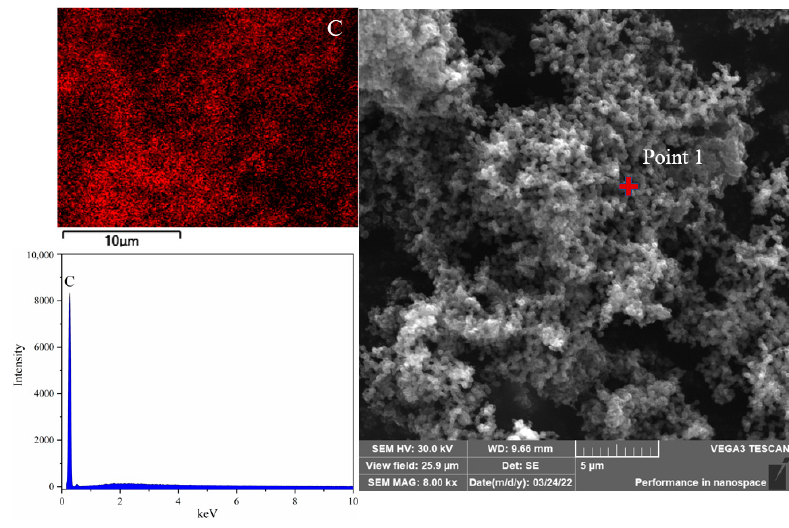
Figure 10. SEM-EDS analysis of cracking carbon.